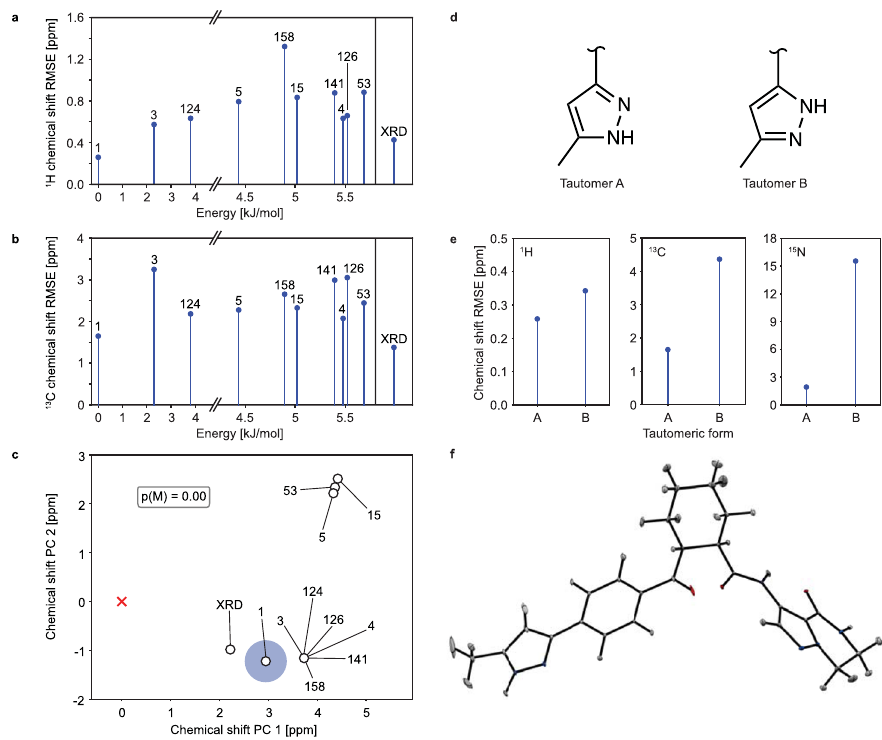
Fig. 2 NMR crystallography of AZD5718. a 1 H and b 13 C chemical shift RMSEs of the ten lowest DFT-D energy CSP candidates and of the crystal structure determined by X-ray diffraction (labelled XRD). The label rank in terms of increasing force- fi eld energy per molecule of ( 1 ) of each candidate is indicated above each point. c Two-dimensional projection of the similarity of the computed 1 H and 13 C chemical shifts of the candidate structures to the experimental data (red cross). The probability of each candidate to match experiment is represented by the area of the blue disk. p(M) denotes the probability that a virtual candidate, which represents structures potentially missing from the CSP candidate pool, matches experiment. The virtual candidate is represented by the mean of the shifts of all CSP candidates, and a high probability p(M) suggests that the CSP candidate pool may not include the experimentally observed structure. d Chemical structures of the two tautomers of 1 considered, labelled as A and B. e Agreement between 1 H, 13 C and 15 N experimental and DFT computed chemical shifts for the two tautomers. f ORTEP plot of the ADP tensors for the NMR structure of 1 drawn at the 90% probability level.